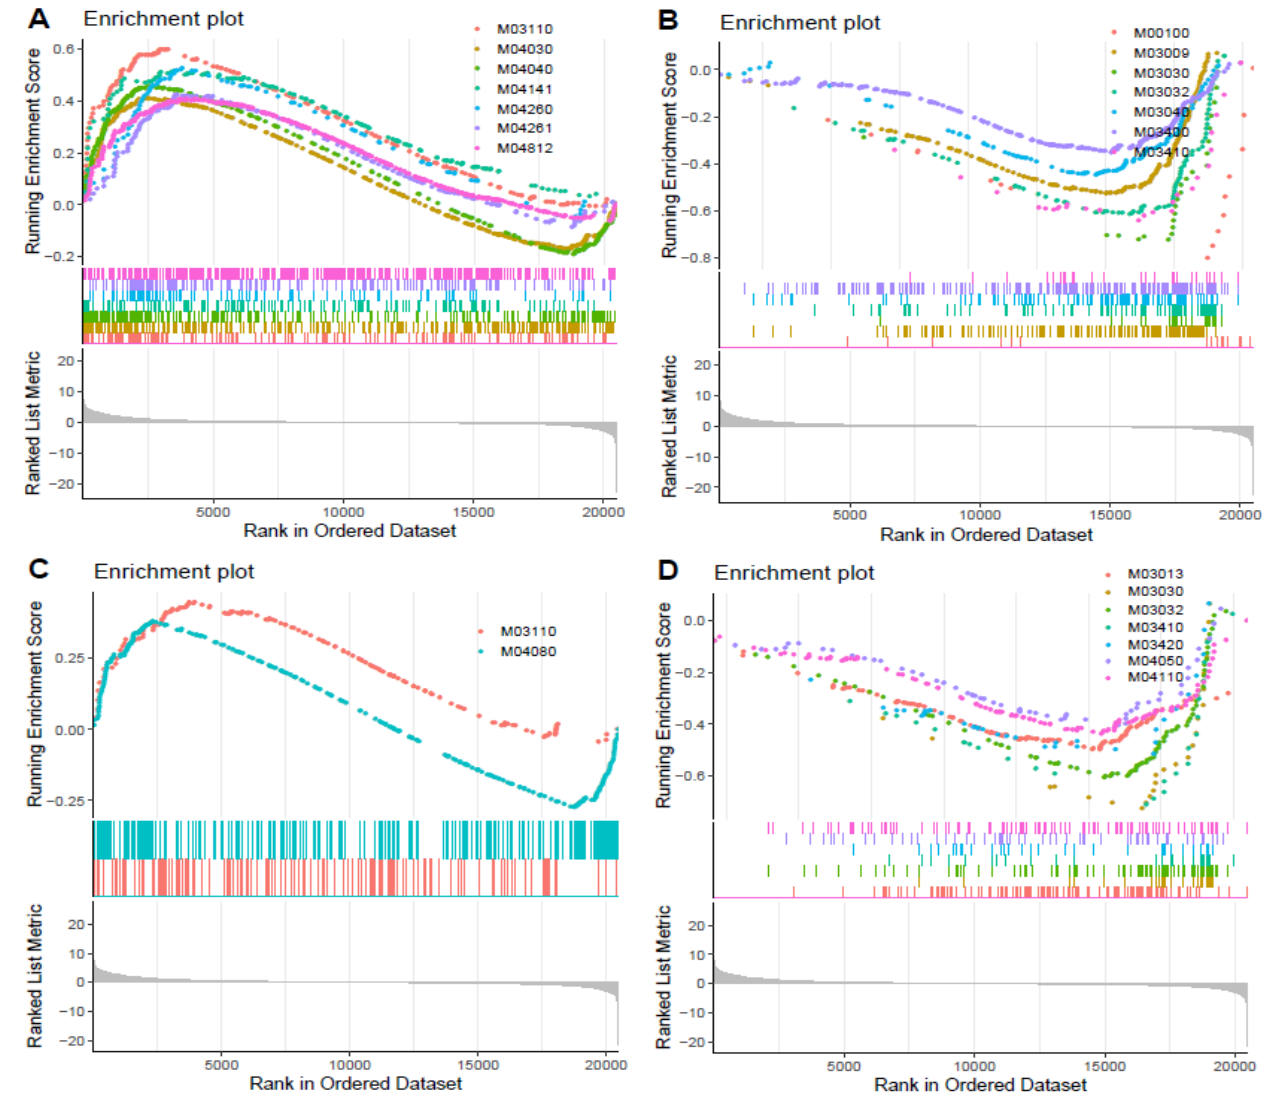
Figure 5. The visualized results of GSEA. The up-regulated pathways after GTR ( A ) are as follows: Chaperones and folding catalysts (M03110), G protein-coupled receptors (M04030), Ion channels (M04040), Protein processing in endoplasmic reticulum (M04141), Cardiac muscle contraction (M04260), Adrenergic signaling in cardiomyocytes (M04261), Cytoskeleton proteins (M04812). The down-regulated pathways after GTR ( B ) are as follows: Steroid biosynthesis (M00100), Ribosome biogenesis (M03009), DNA replication (M03030), DNA replication proteins (M03032), Spliceosome (M03040), DNA repair and recombination proteins (M03400), Base excision repair (M03410). The up-regulated pathways after ATR ( C ) are as follows: Chaperones and folding catalysts (M03110), Neuroactive ligand–receptor interaction (M04080). The down-regulated pathways after ATR ( D ) are as follows: RNA transport (M03013), DNA replication (M03030), DNA replication proteins (M03032), Base excision repair (M03410), Nucleotide excision repair (M03420), Cytokine receptors (M04050), Cell cycle (M04110).